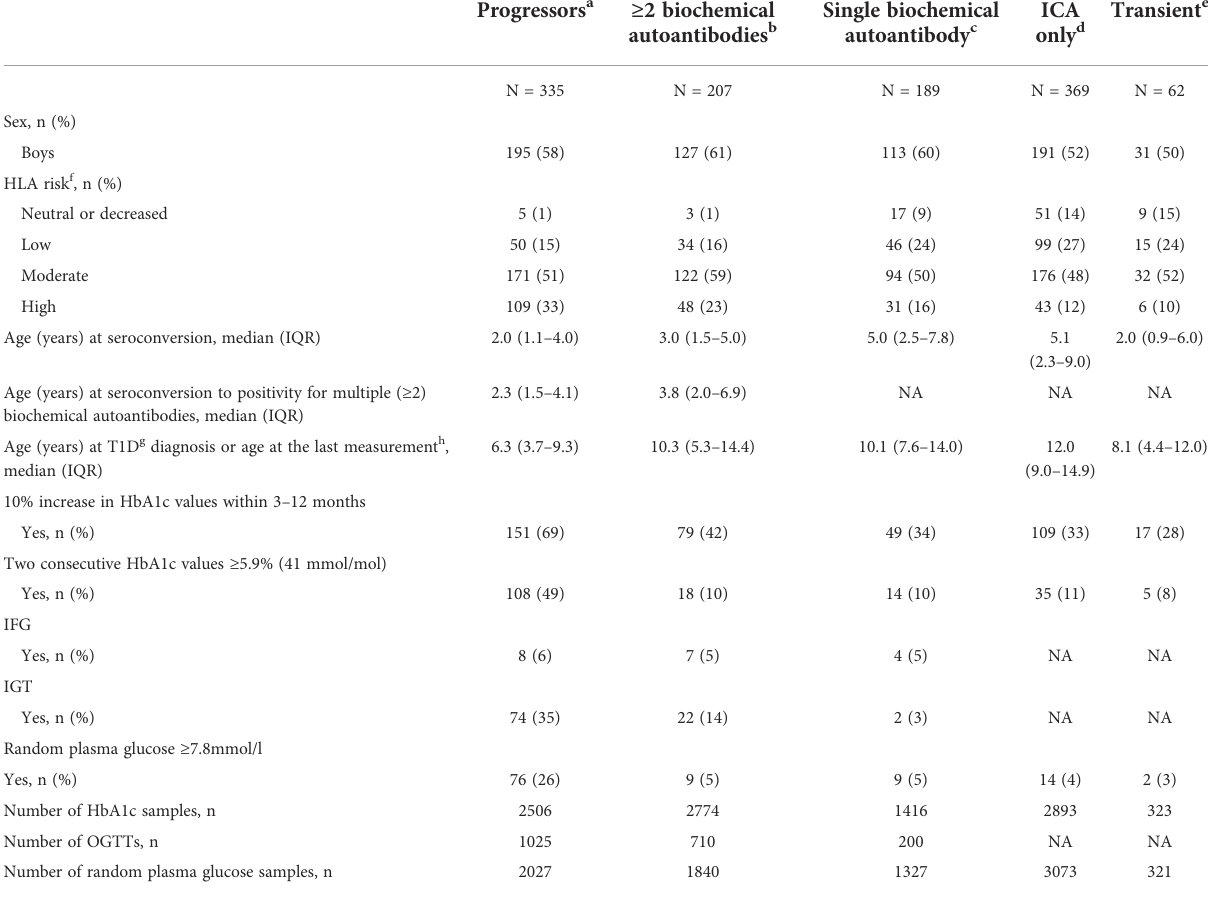
TABLE 1 Baseline characteristics and frequencies of studied types of dysglycemia in fi ve groups of children with varying risk for type 1